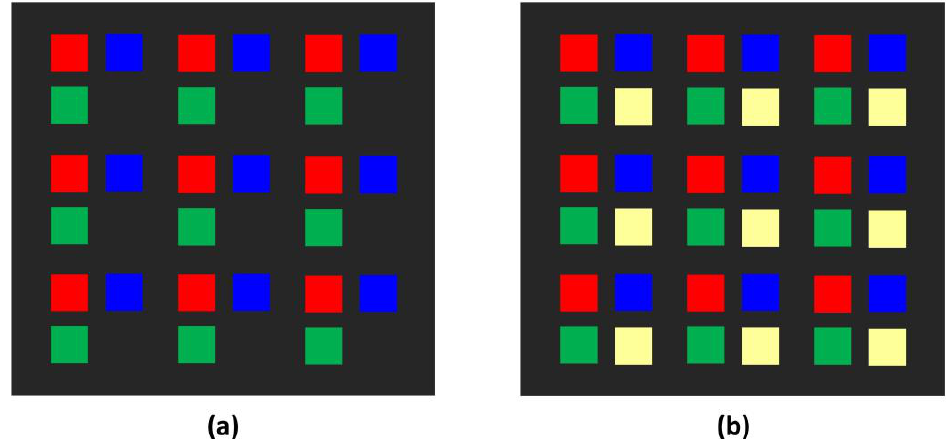
Figure 2. An example of pixel arrangements of ( a ) three-color micro-light-emitting diode (LED) displays and ( b ) four-color micro-LED displays.